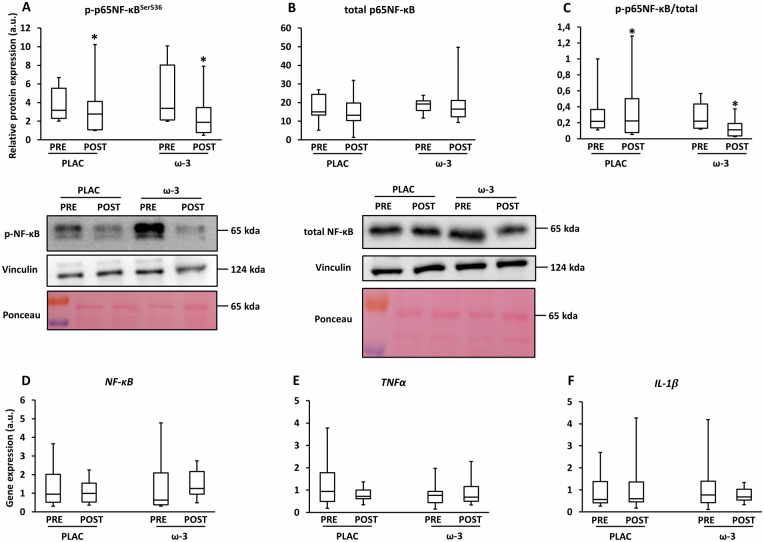
Expression of inflammatory markers in skeletal muscle tissue before (PRE) and after (POST) 12-week resistance exercise in the placebo (PLAC) and omega-3 (ω-3) group. (A) Phosphorylation of the p65 subunit of the NF-kappa-B transcription complex at the Ser536-site (p-p65NF-κBSer536), (B) total p65NF-κB, (C) p-p65NF-κBSer536/total p65NF-κB, (D) NF-κB gene expression, (E) tumor necrosis factor alpha (TNFα) gene expression, (F) interleukin-1β (IL-1β) gene expression. For all boxplots, the box represents the interquartile range, the horizontal line in the box represents the median, and the error bars represent the maximum and minimum values. Data were analyzed with a 2-way repeated measures ANOVA to detect differences over time (PRE vs POST) and between groups (PLAC vs Ω-3). *p < .05 (POST vs PRE).